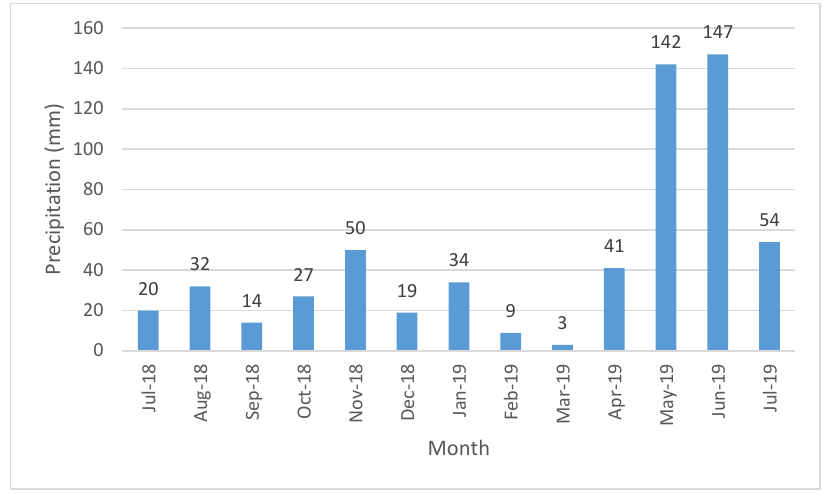
Figure 2. Precipitation of the study area before and within the study period.